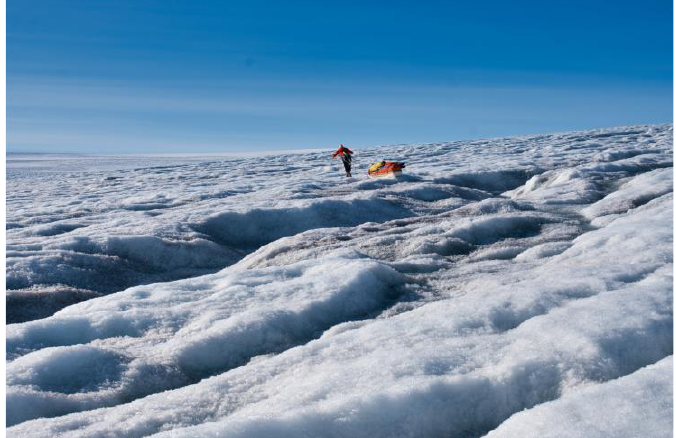
Figure 8. Meltwater channels during the expedition 2020 on the east coast.